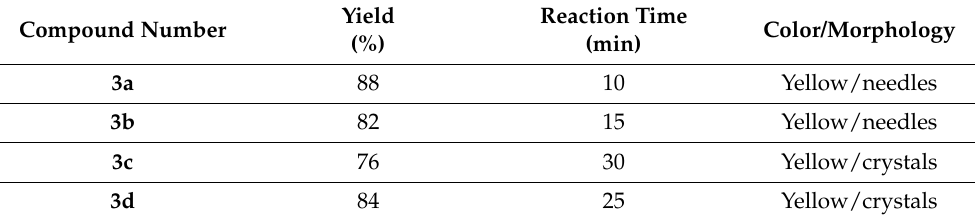
Table 1. Physical data of compounds 3a–d .